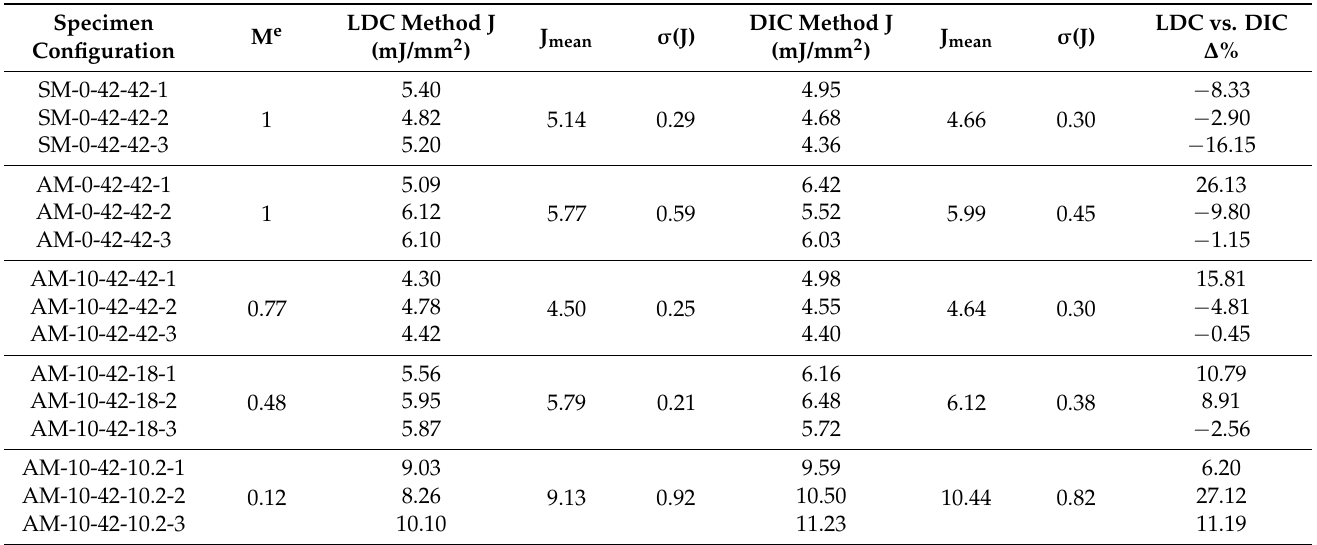
Table 4. Results of the J-integral computed with the load–displacement curves (LDC) method and with the DIC method. Specimen